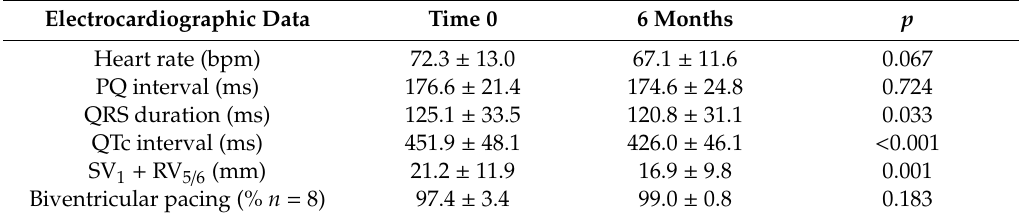
Table 2. Electrocardiographic data before and after six months of Sacubitril / Valsartan (LCZ696) therapy. Electrocardiographic Data